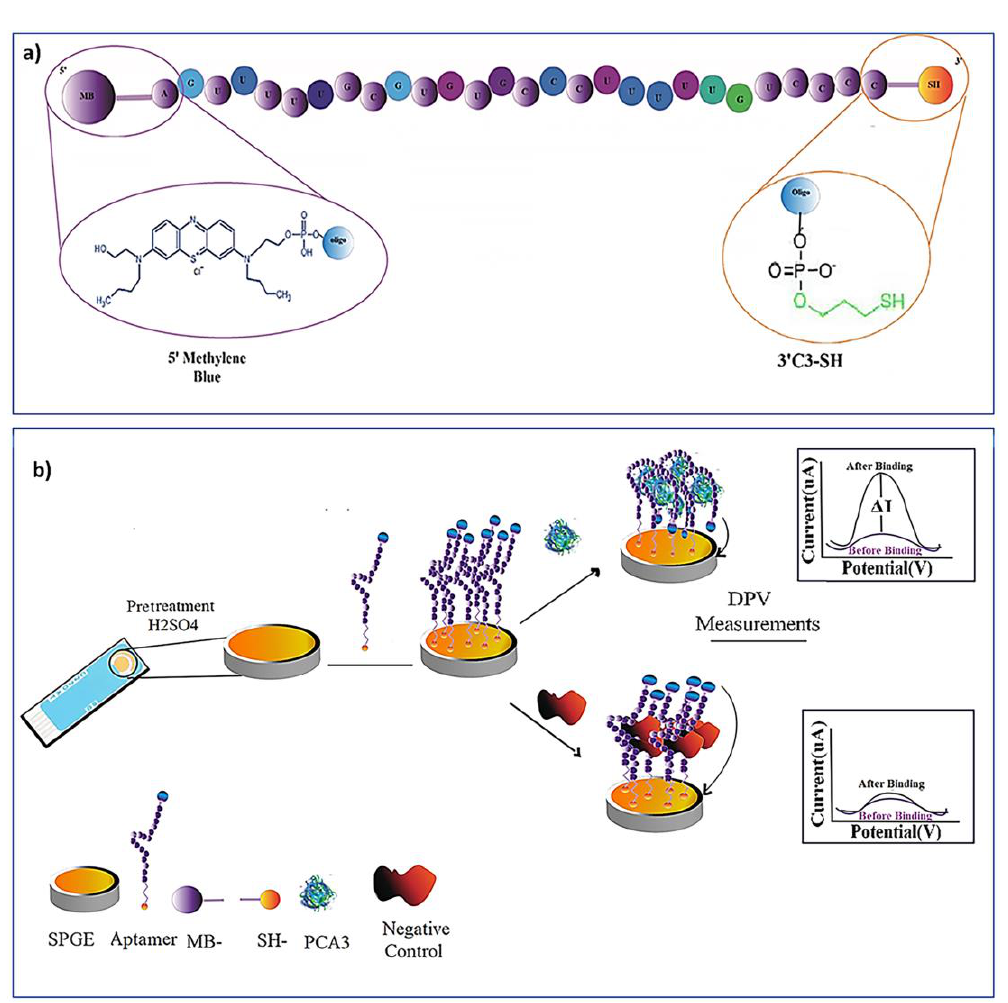
Figure 1. ( a ) Chemical structure of RNA aptamer specific to PCA3, including the functional groups of SH at the 3′ terminal and methylene blue at the 5′ terminal. ( b ) The fabrication and detection steps of a DPV aptasensor.